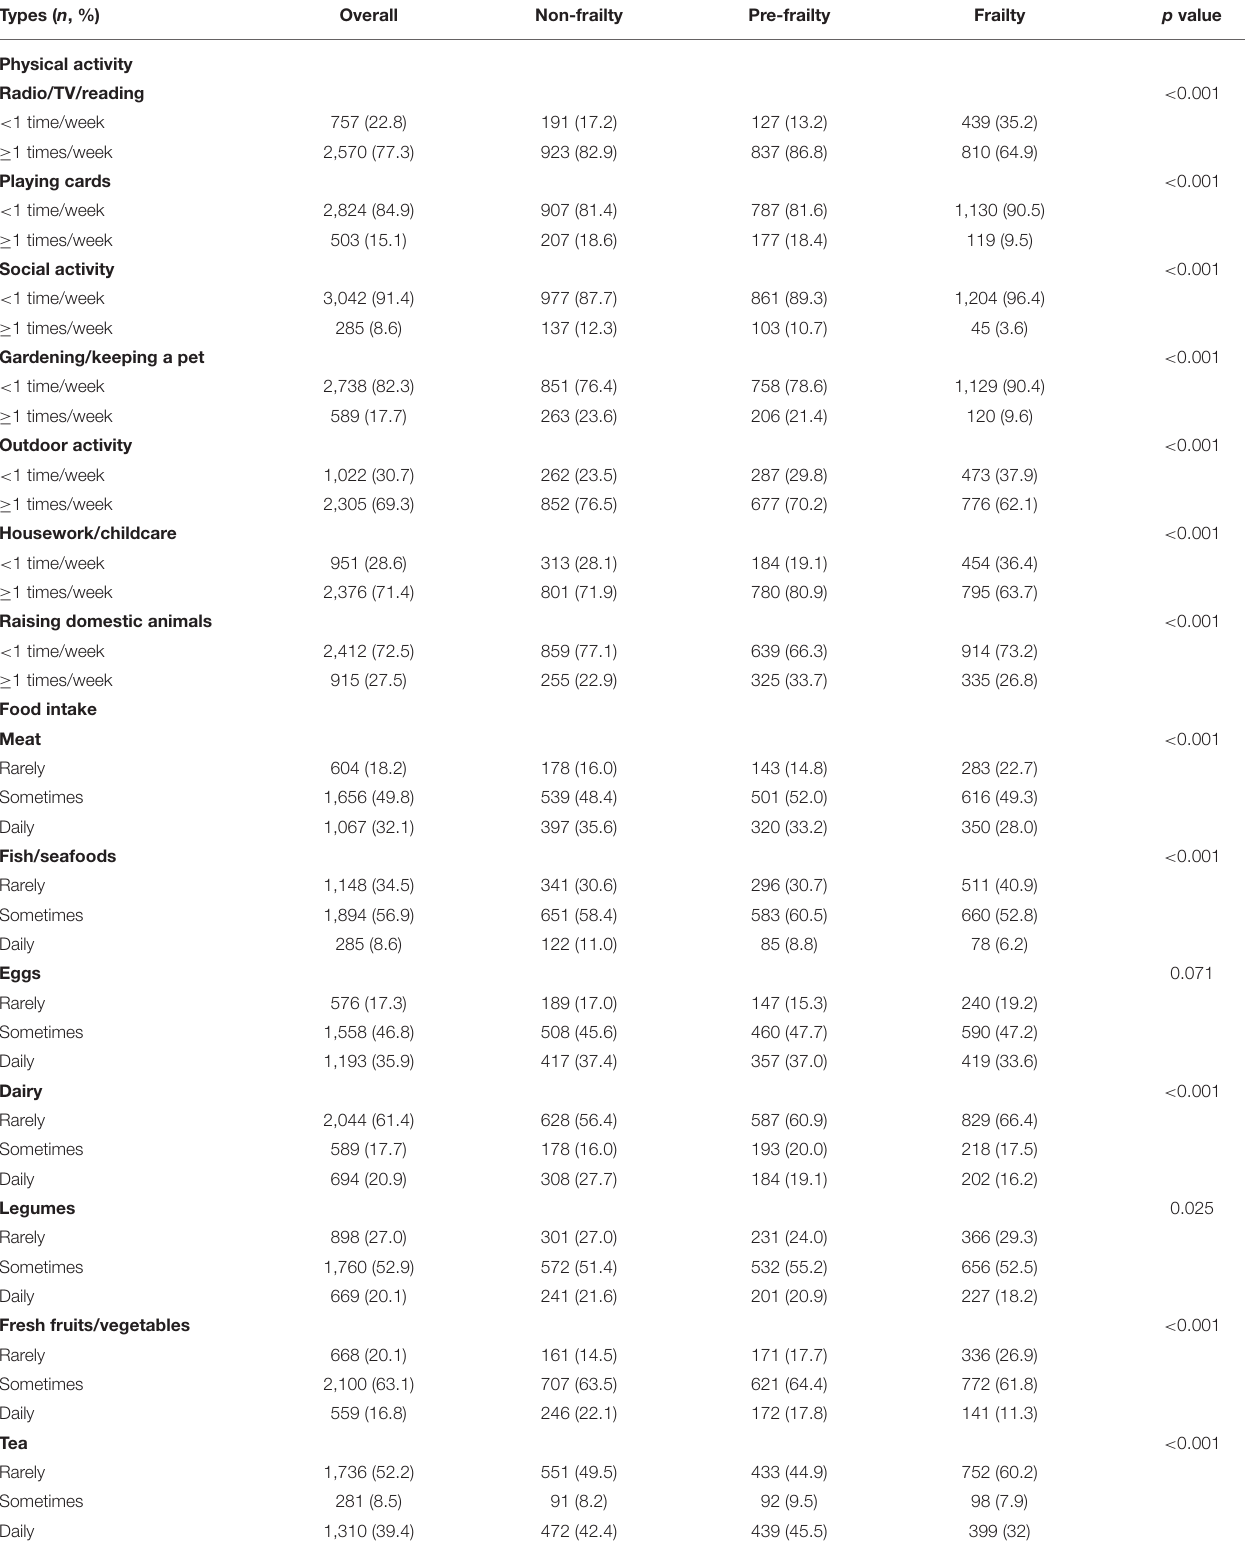
TABLE 2 | Comparison of types of food intake and types of physical activity at baseline according to the status of frailty during the follow-up. Types ( n ,